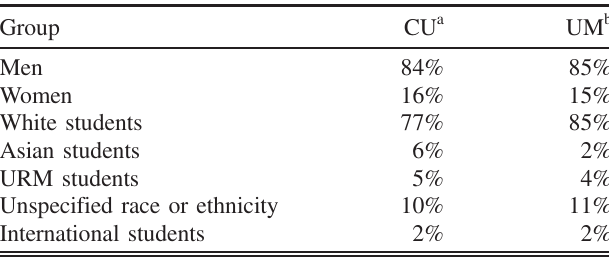
TABLE I. Demographic breakdown of physics and